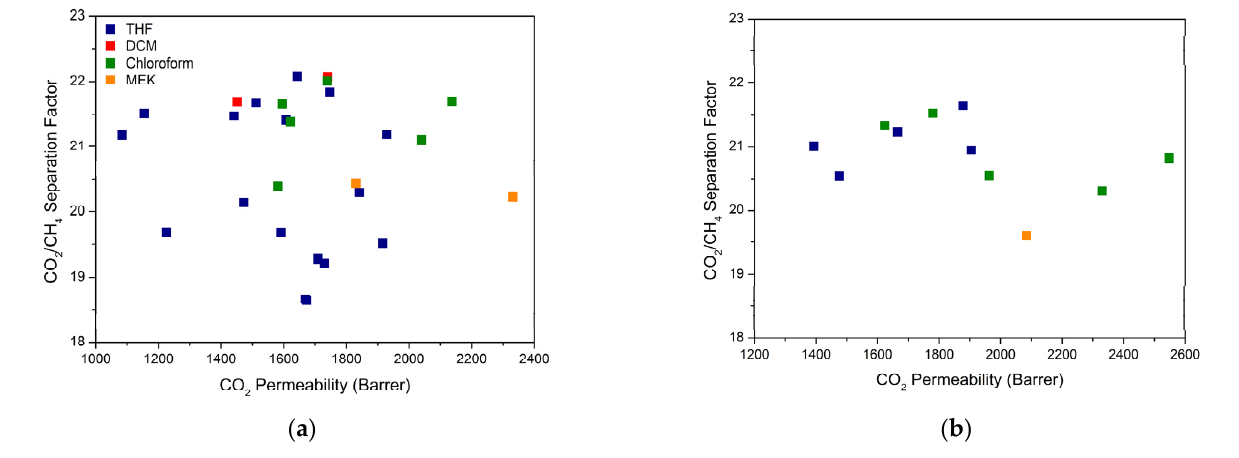
Figure 5. Permeability/separation map showing mixed-gas data measured at 2 bar and 35 °C with 50/50 (vol.%) CO 2 /CH 4 mixture for MOF-808/6FDD MMMs containing ( a ) 10 wt.% and ( b ) 30 wt.% filler, which were prepared under different synthesis conditions, labeled here by solvent from which the membranes were cast.